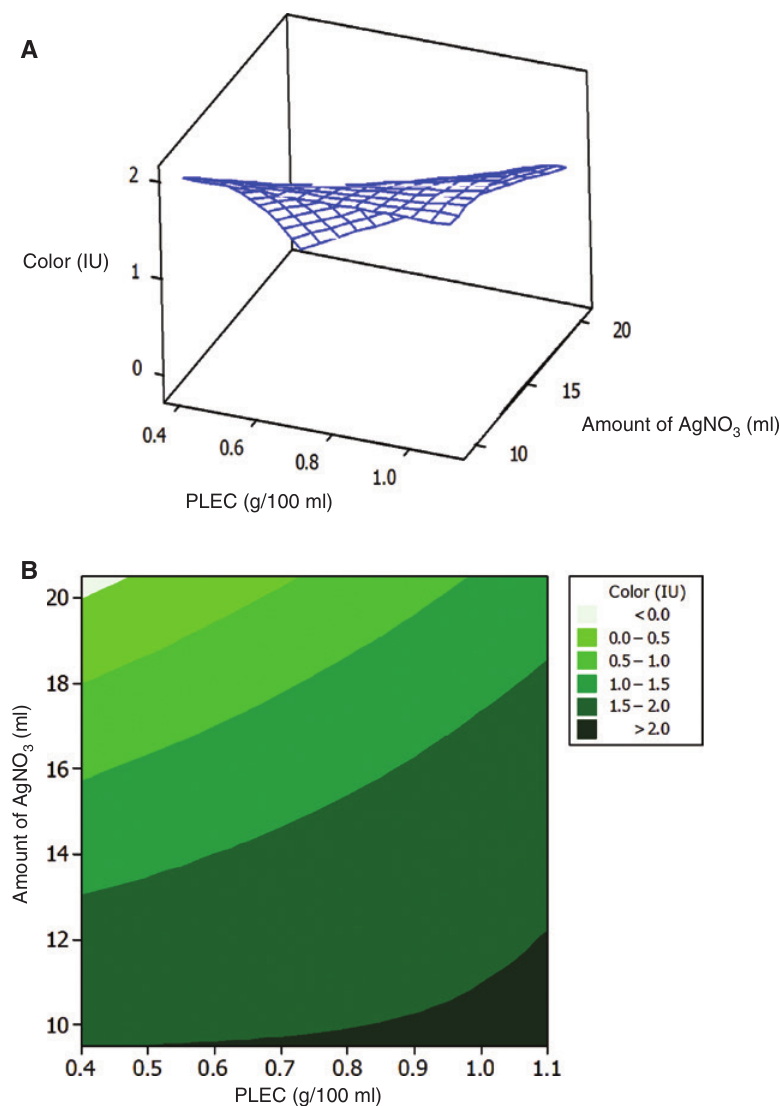
(ml) and PLEC (g/100 ml). 3